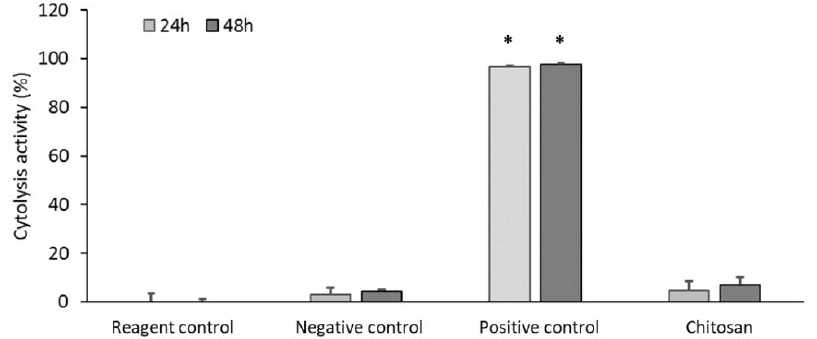
Figure 2. Biocompatibility of chitosan dressing (test product) evaluated through cytolysis activity measurement (* p < 0.05; 24 and 48 h incubation).